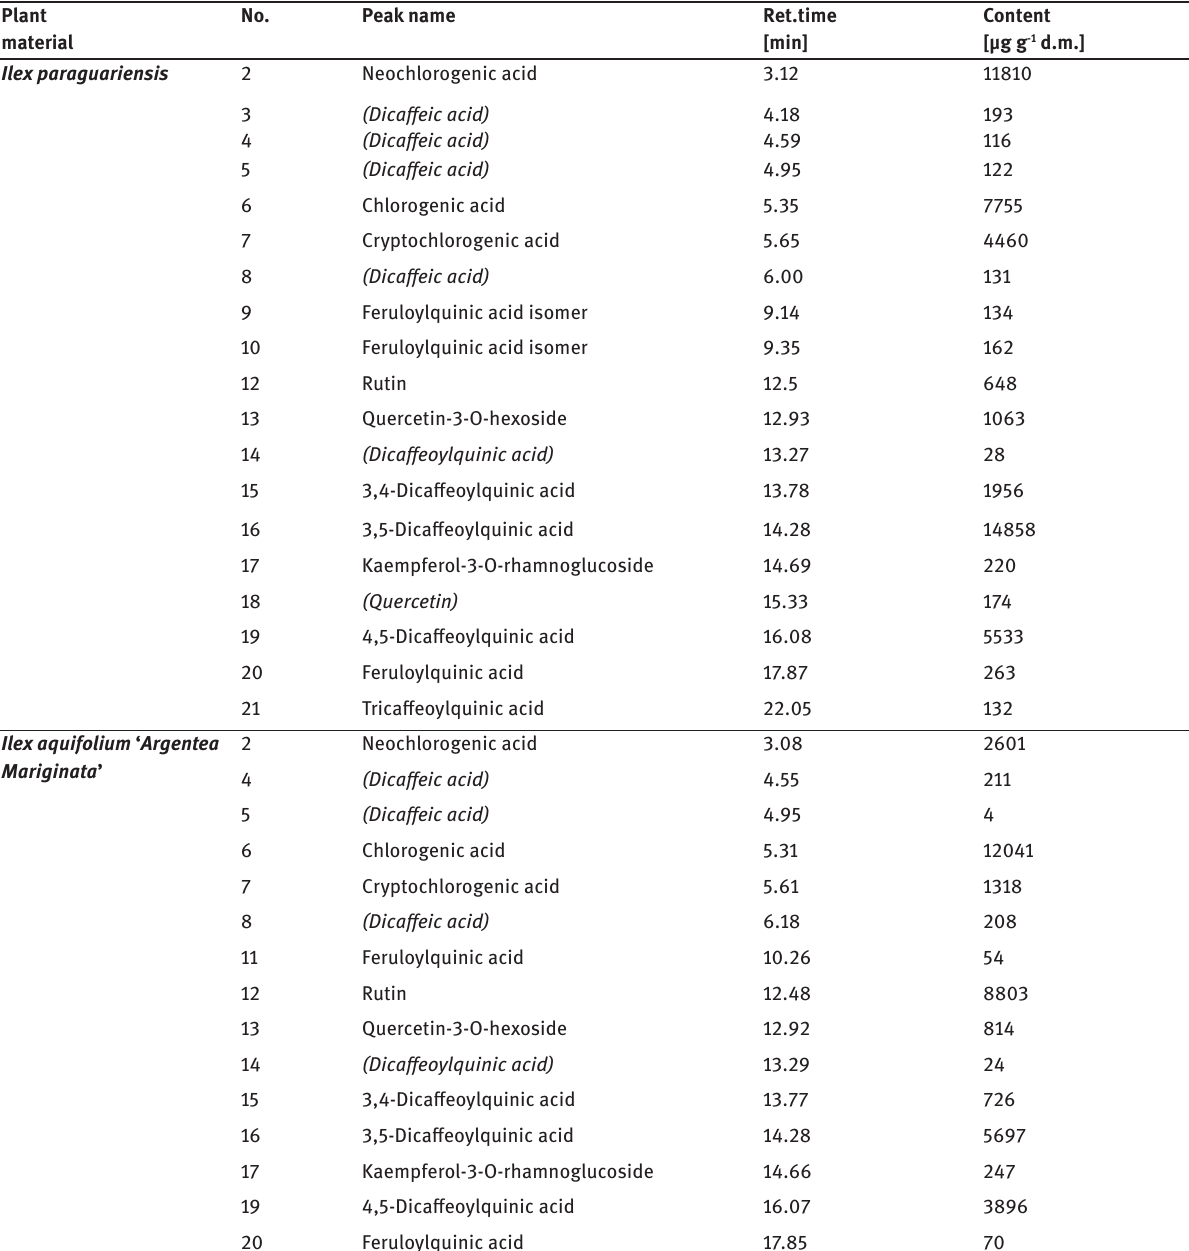
Table 4: HPLC DAD characteristics of phenolic compounds in Ilex sp. Plant